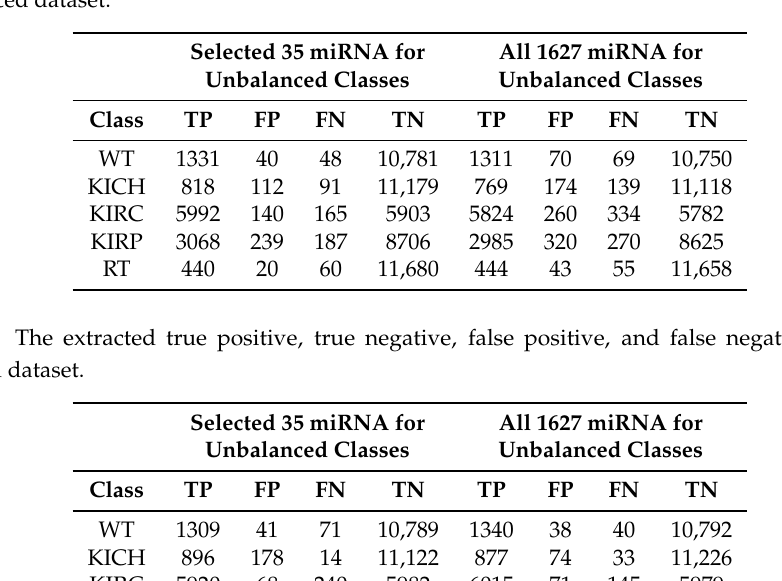
Table 3. The extracted true positive, true negative, false positive, and false negative from the unbalanced dataset.